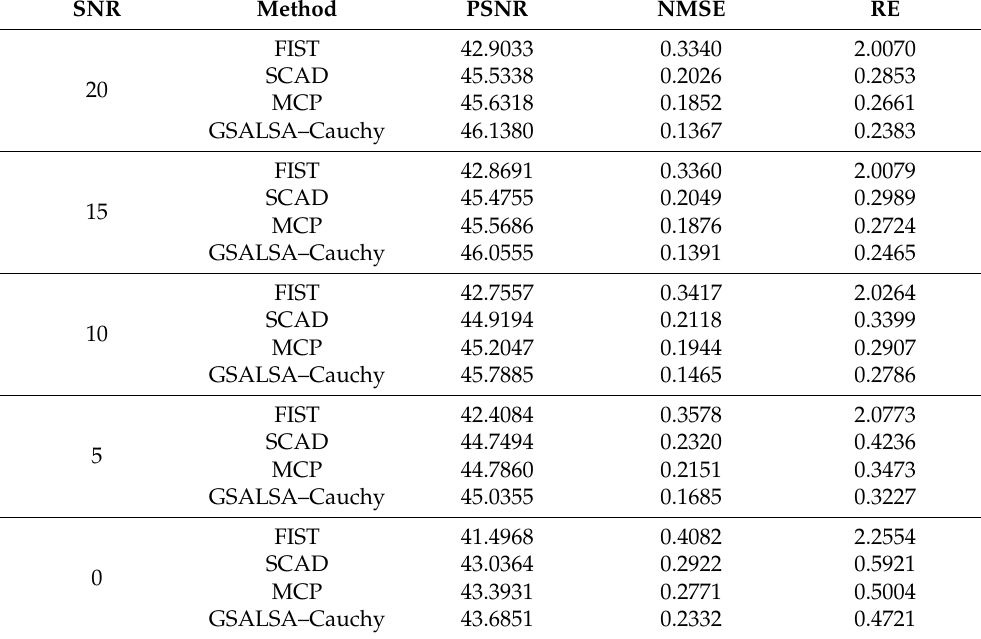
Table 7. PSNR, NMSE and RE of aircraft model under different SNR.